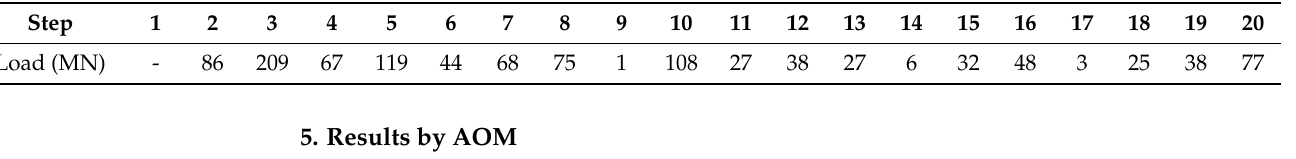
Figure 8. The shape of surface loads in different cases: ( a ) uniform load in Case 1; ( b ) non-uniform load in Case 2; ( c ) the load shape of each step in Case 3. Table 3. The value of each load step in Case 3.